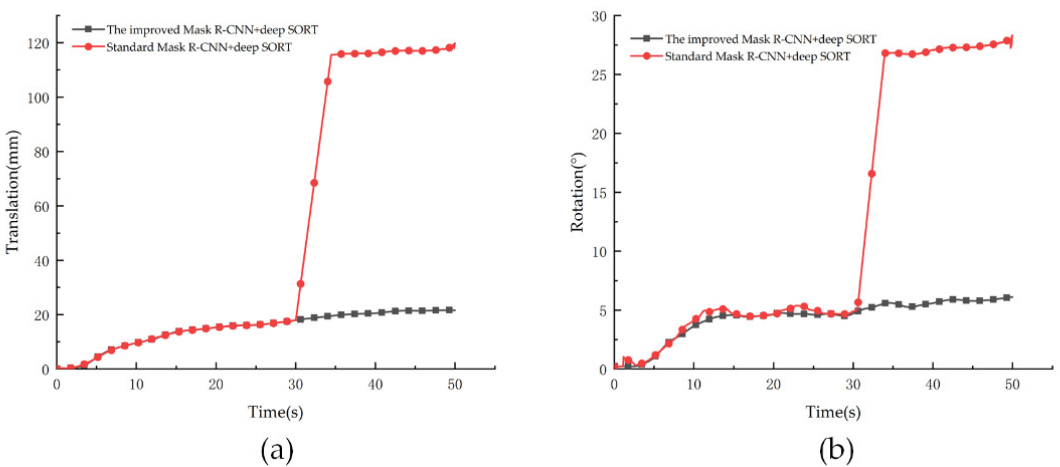
Figure 10. The example of the failure of standard Mask R-CNN and Deep SORT. ( a ) is the translation comparison chart. ( b ) is the rotation comparison chart.